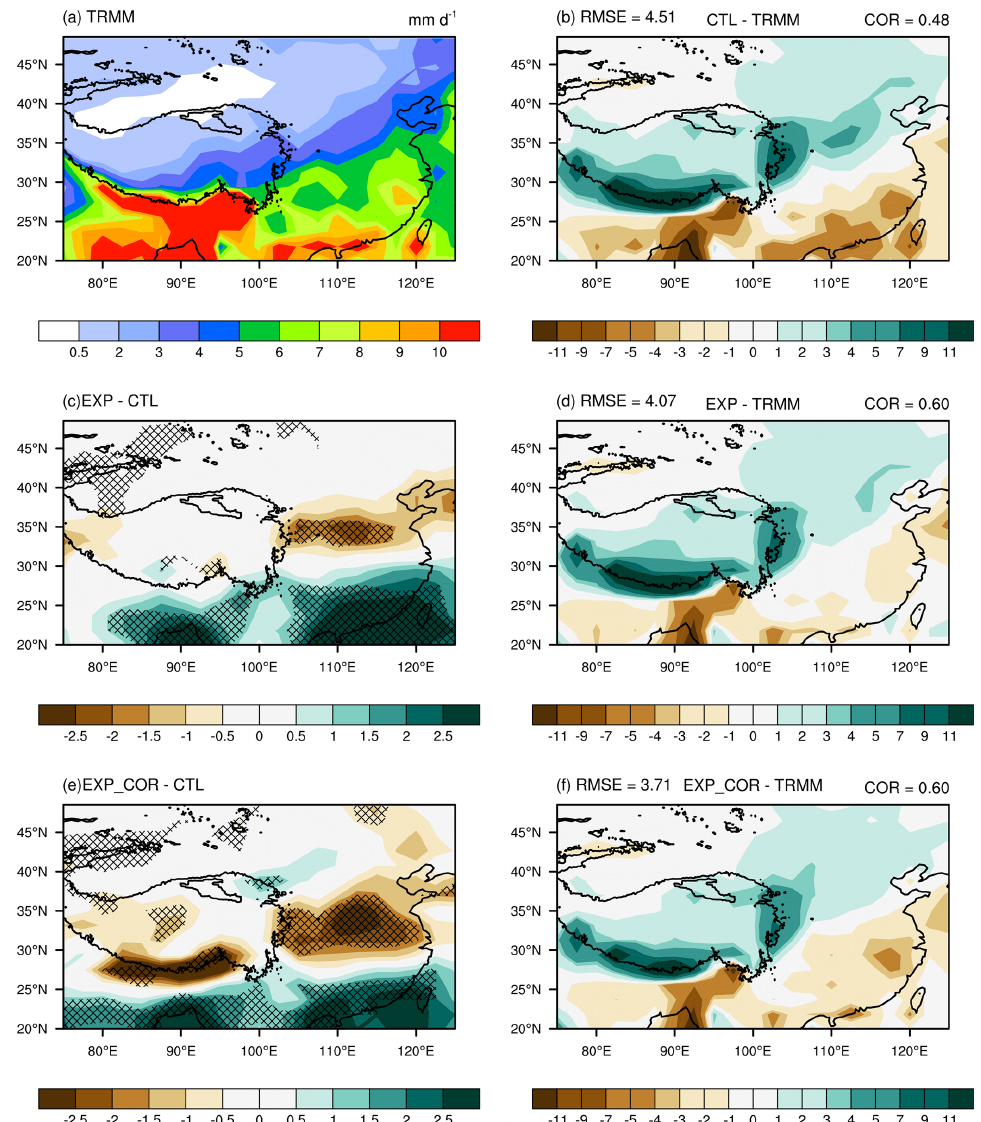
Figure 4. The same as Fig. 3 but focusing on the study area (20–50 ◦ N, 75–125 ◦ E). The regionally averaged spatial COR and RMSE are given at the top of (b) , (d) and (f)